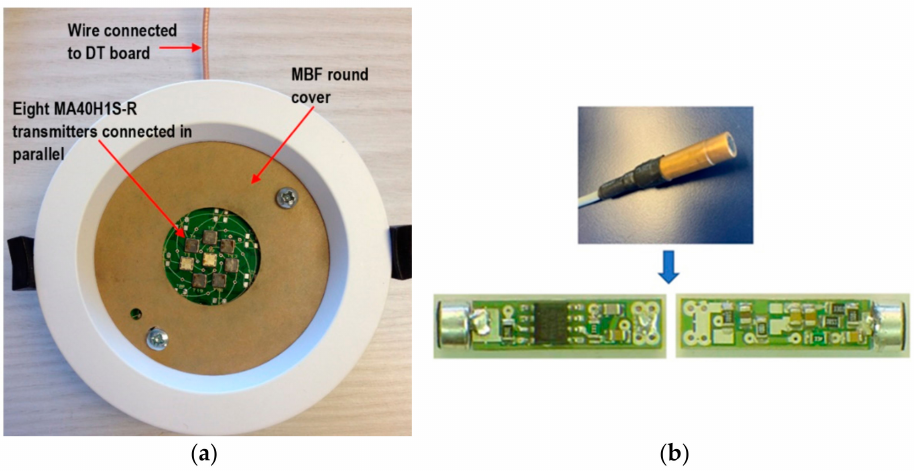
Figure 5. The US transmitter board containing eight surface mount transducers is shown in photo ( a ). The receiver unit composed of a Panasonic WM61A microphone and pre-amplifier is shown in photo ( b ). The ultrasonic excitation signal applied to the transducers was a linear chirp signal.